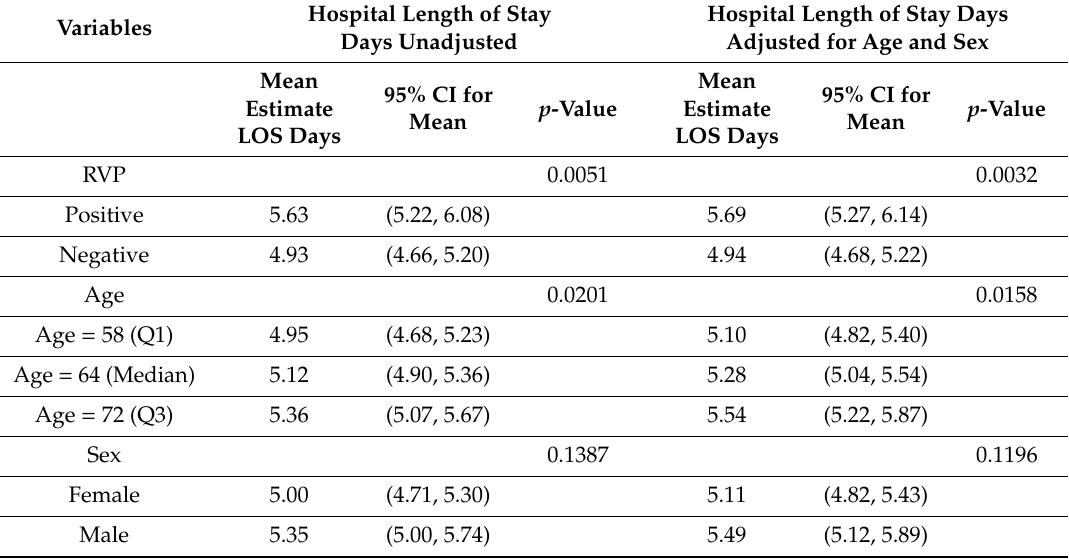
Table 3. Hospital length of stay day’s crude and adjusted multivariable model